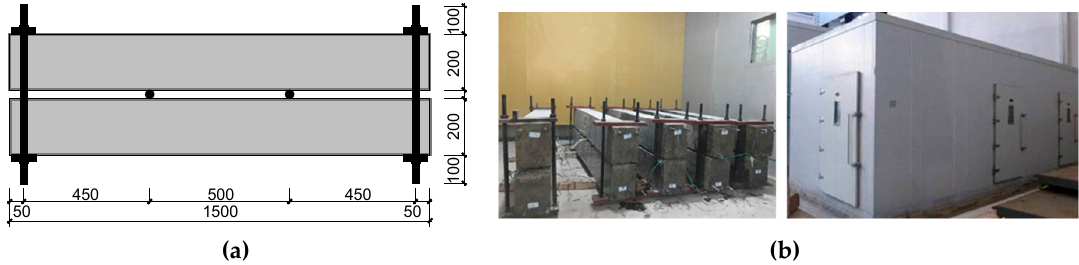
Figure 4. Artificial acceleration simulation carbonation environmental test: ( a ) specimen preparation (mm) and ( b ) carbonation test in the environmental chamber.